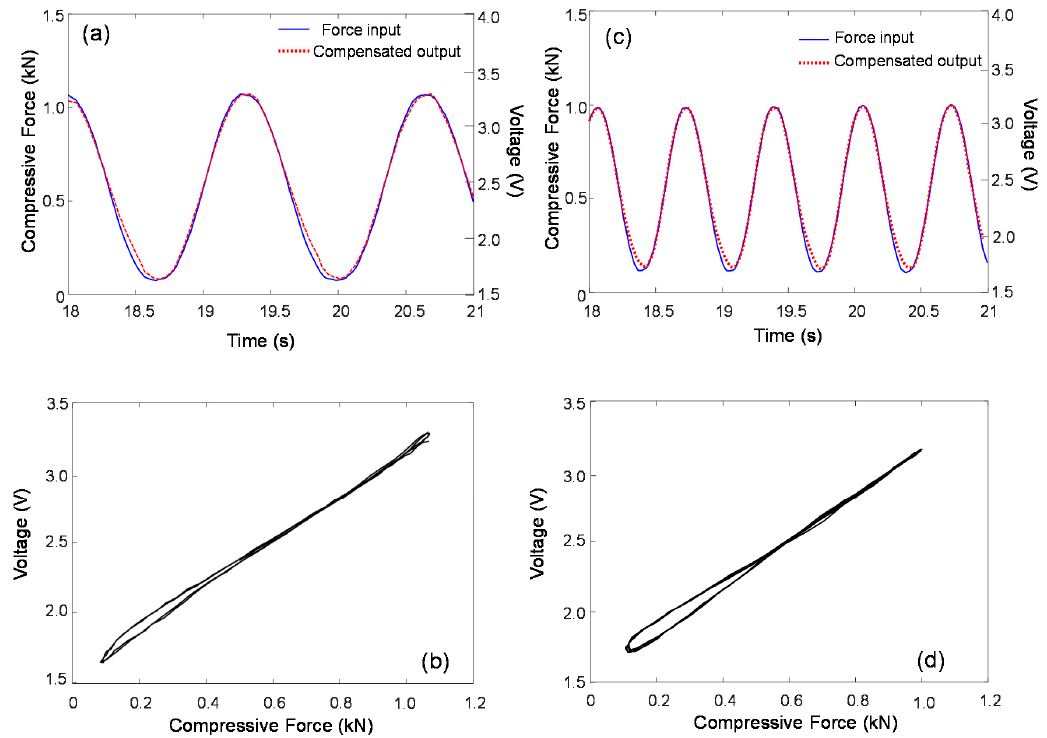
Figure 11. Hysteresis-compensated force responses. ( a , b ) 0.75 Hz; ( c , d ) 1.5 Hz.